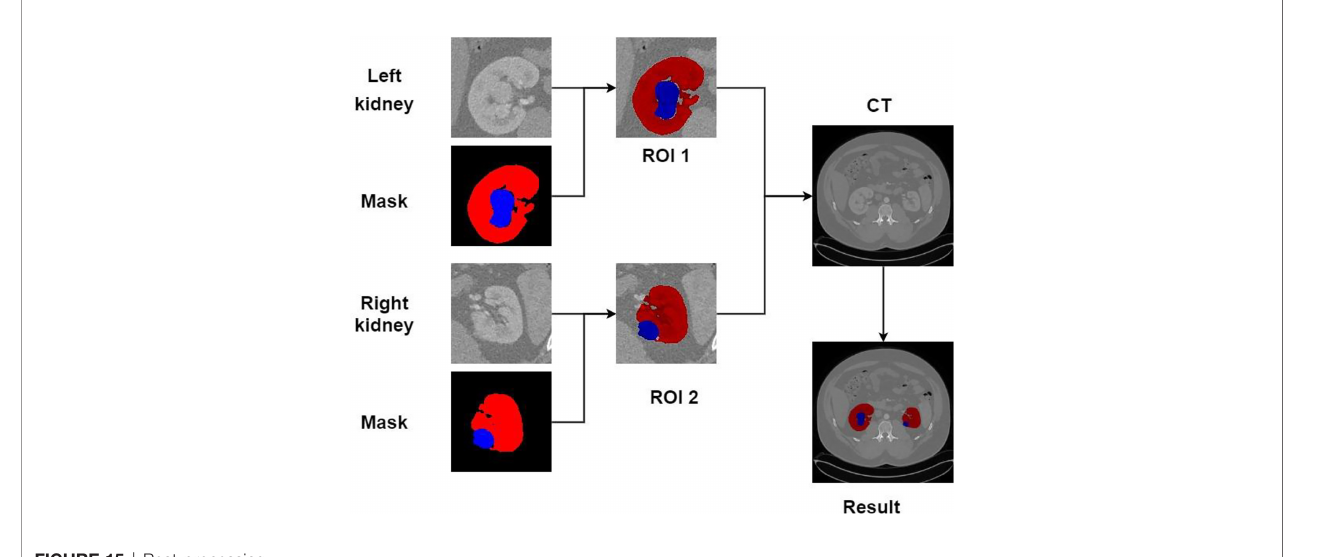
FIGURE 15 | Post-processing.